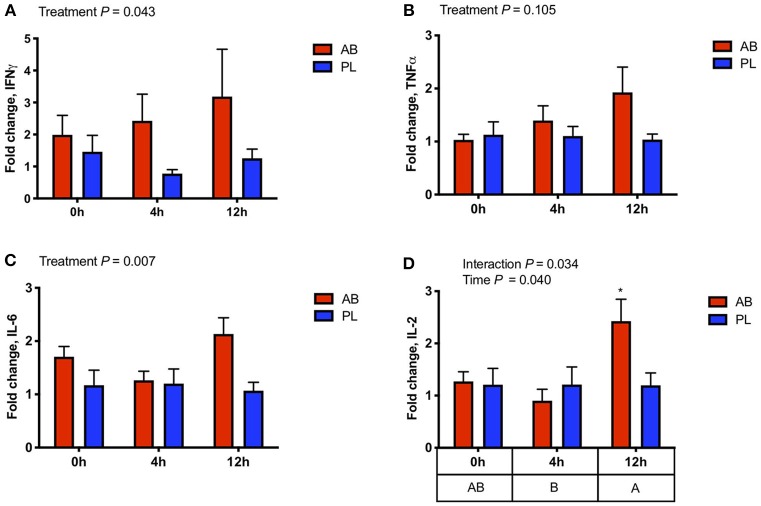
Gene expression of effector cytokines in whole blood was altered 0, 4, and 12 h post intraperitoneal Salmonella challenge in pigs treated with antibiotics (AB) vs. placebo (PL) as analyzed by a Two-way ANOVA (A) IFNγ expression was higher in AB vs. PL treated pigs (Treatment P = 0.043, Time P = 0.715, Interaction P = 0.647). (B) TNFα expression tended to be higher with AB treatment (Treatment P = 0.105, Time P = 0.192, Interaction P = 0.338). (C) IL-6 expression was also higher in AB vs. PL treated pigs (Treatment P = 0.007, Time P = 0.312, Interaction P = 0.125). (D) There was an interaction between time and treatment on the expression of IL-2 and was increased in AB treated pigs 12 h post-challenge compared to AB and PL treated pigs at all time points as indicated by an asterisk (Treatment P = 0.186; Time P = 0.040, Interaction P = 0.034) n = 7/treatment. The main effect of time is displayed below the figure and those time points not sharing a common letter differ significantly. Post-hoc pair-wise comparisons made with Bonferroni correction.